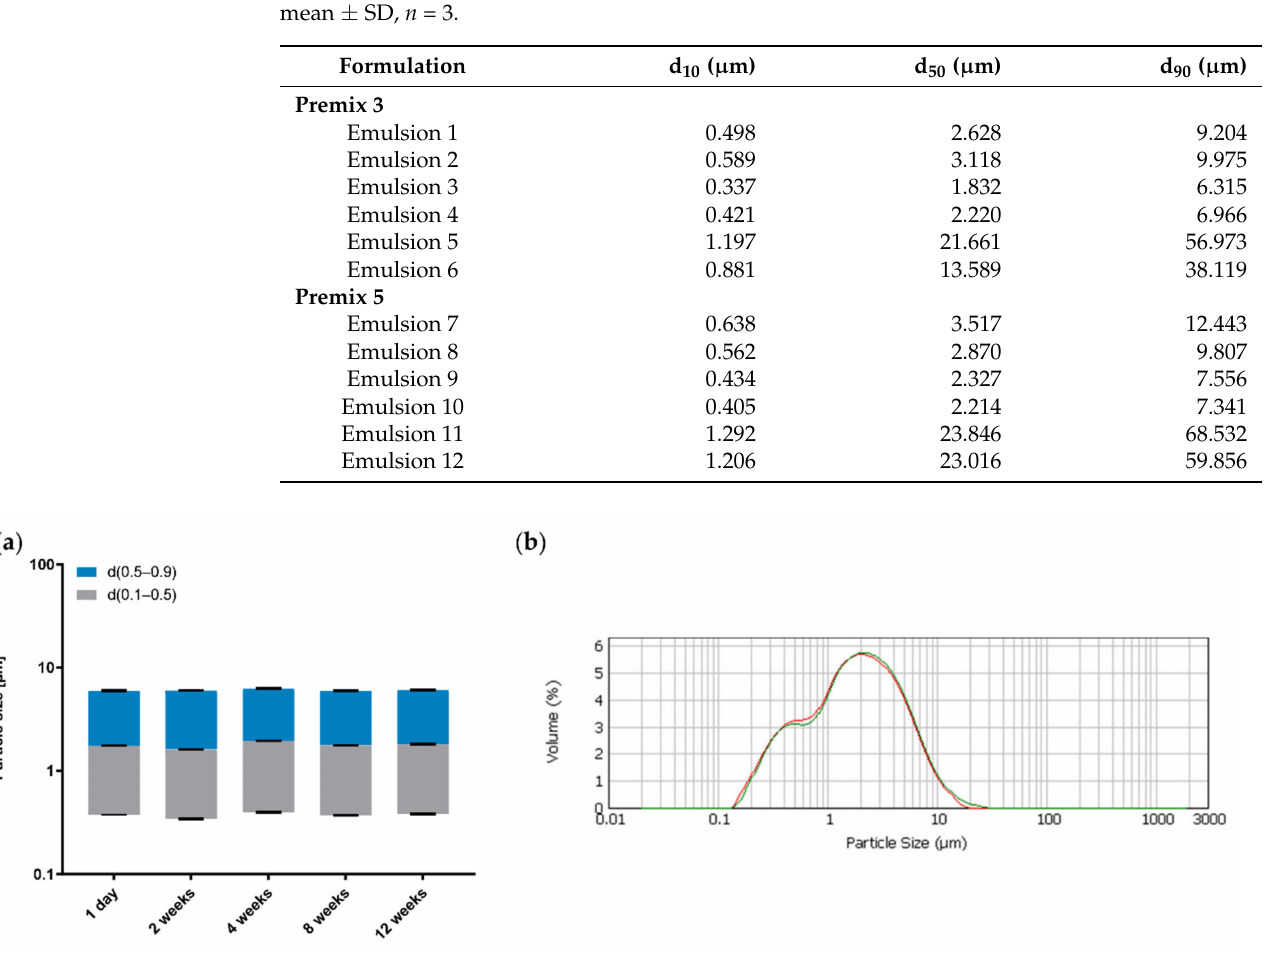
Figure 9. ( a ) The d 10 , d 50 and d 90 values during storage. ( b ) Volume-based droplet size distribution on 1 day (red) and 12 weeks (green) after preparation; mean ± SD, n =